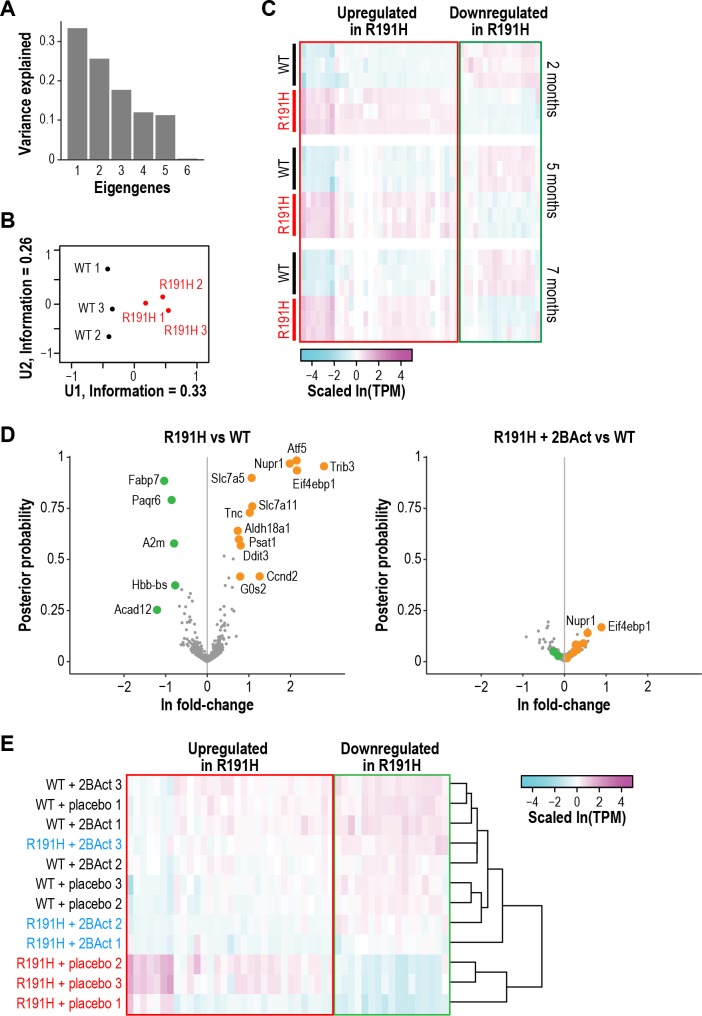
R191H mice have an abnormal brain transcriptome at 2 months of age that is normalized by 2BAct treatment.(A) Scree plot showing the variance explained by each component of the SVD analysis of 2-month-old WT and R191H cerebellum. (B) Individual 2-month-old cerebellum samples plotted along the first and second components of SVD analysis. (C) Heatmap of gene expression changes in WT and R191H cerebellum at 2, 5, and 7 months of age (N = 3/genotype/time point). Shown are the 50 genes with the largest absolute loadings in the first eigengene from SVD analysis of 2 month samples. Source data for (A) -(C) are available in Figure 4—source data 1. (D) Volcano plots showing gene expression changes between R191H and WT (left) and R191H + 2 BAct and WT (right). Orange and green dots indicate transcripts that were more than 2X increased or decreased, respectively, in the R191H vs. WT plot. These dots are replicated on the R191H + 2 BAct vs. WT plot for comparison. (E) Heatmap of gene expression changes in WT and R191H cerebellum treated with placebo or 2BAct for 4 weeks. Genes are the same set plotted in Figure 4C. Colors indicate the scaled ln(TPM) from the mean abundance of the gene across all samples. For (D) and (E), N = 3/condition. Source data for (D) and (E) are available in Figure 4—source data 2.10.7554/eLife.42940.019Figure 4—source data 1.Fold-changes of transcripts identified in RNA-seq of 2-, 5- and 7-month-old cerebellum.10.7554/eLife.42940.020Figure 4—source data 2.Fold-changes of transcripts identified in RNA-seq in the 4-week 2BAct treatment experiment.